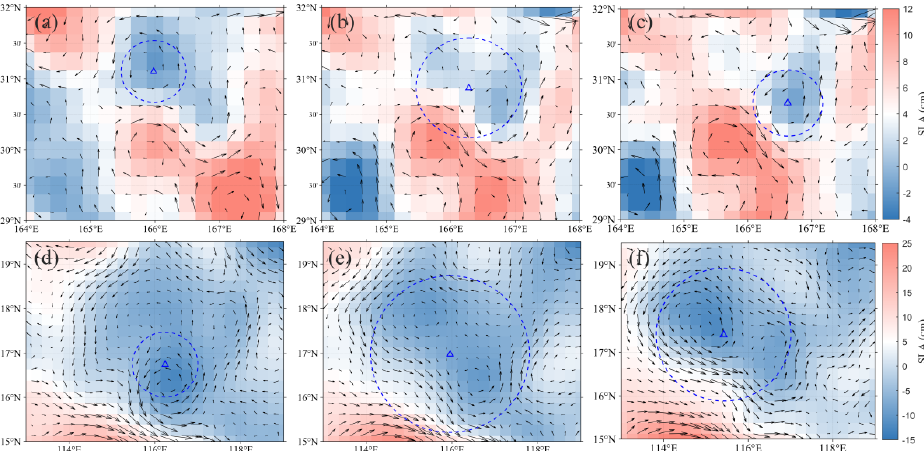
Figure 23. Two cases of tracking error of the META dataset. The jumping process of the first case in